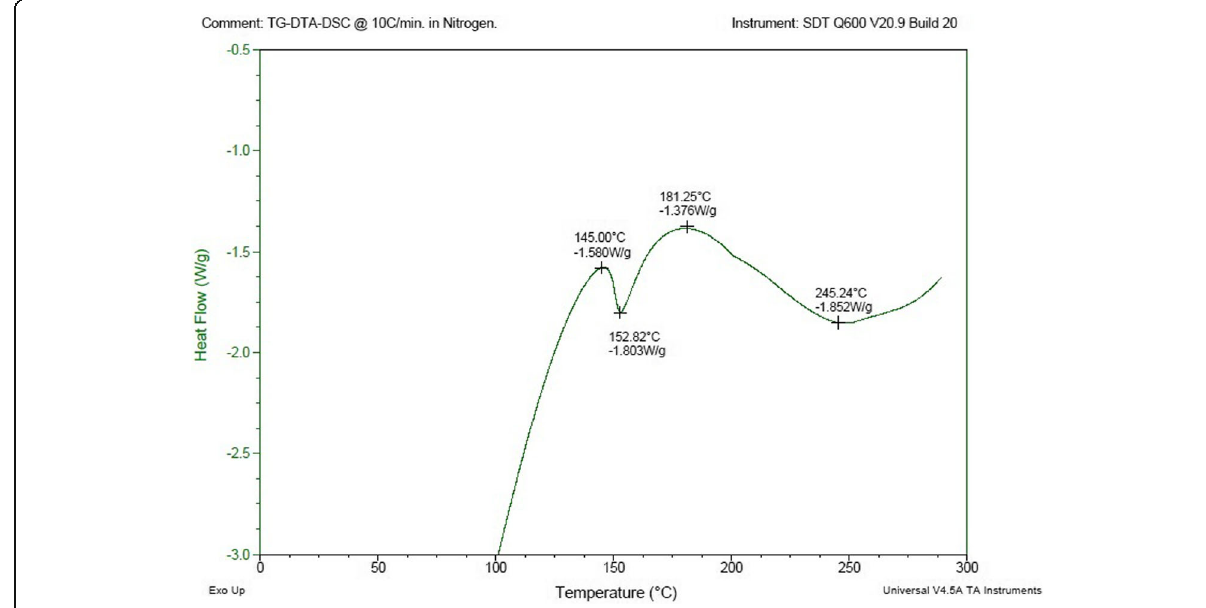
Fig. 5 DSC thermogram of camptothecin herbal